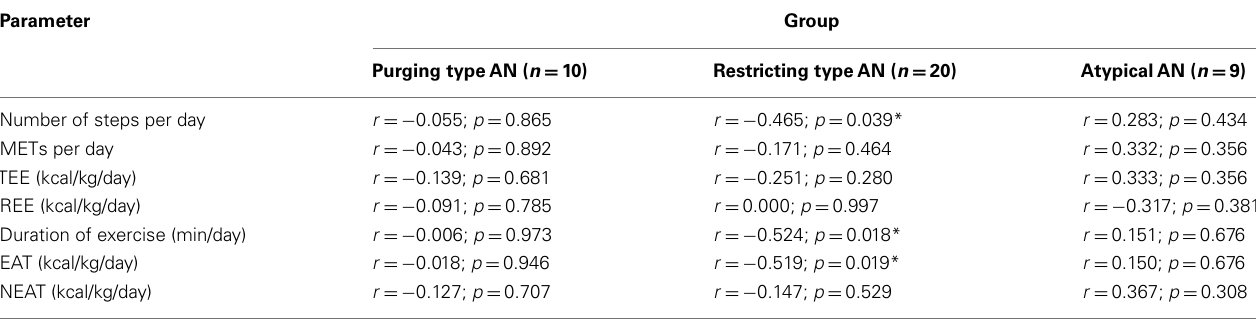
Table 2 | Correlation of irisin with parameters of energy expenditure according to the subtype of anorexia nervosa .